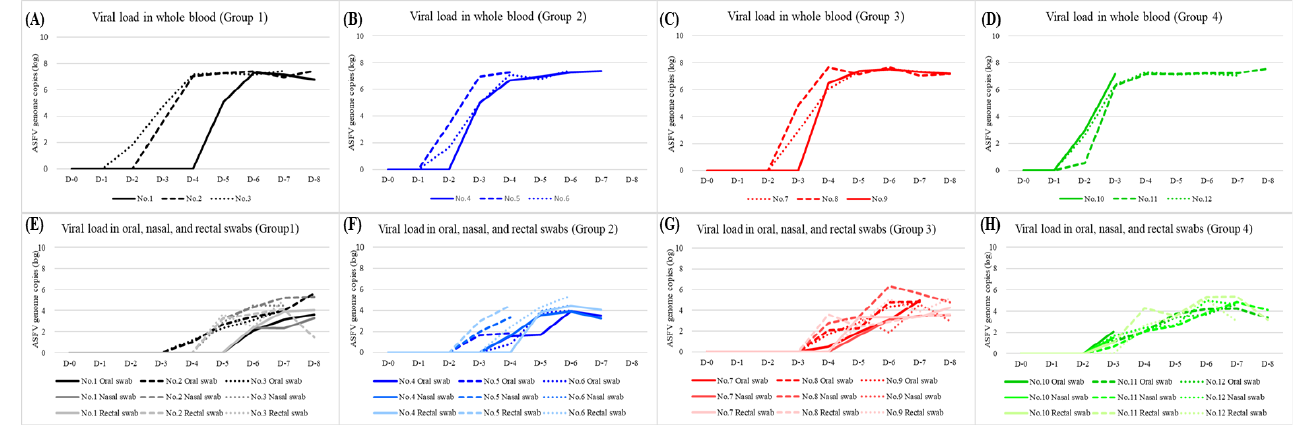
Figure 3. Detection of ASFV genome in whole blood and oral, nasal, and rectal swab samples from the four groups. Viral loads in whole blood ( A – D ) and in oral, nasal, and rectal swabs ( E – H ) of four group.